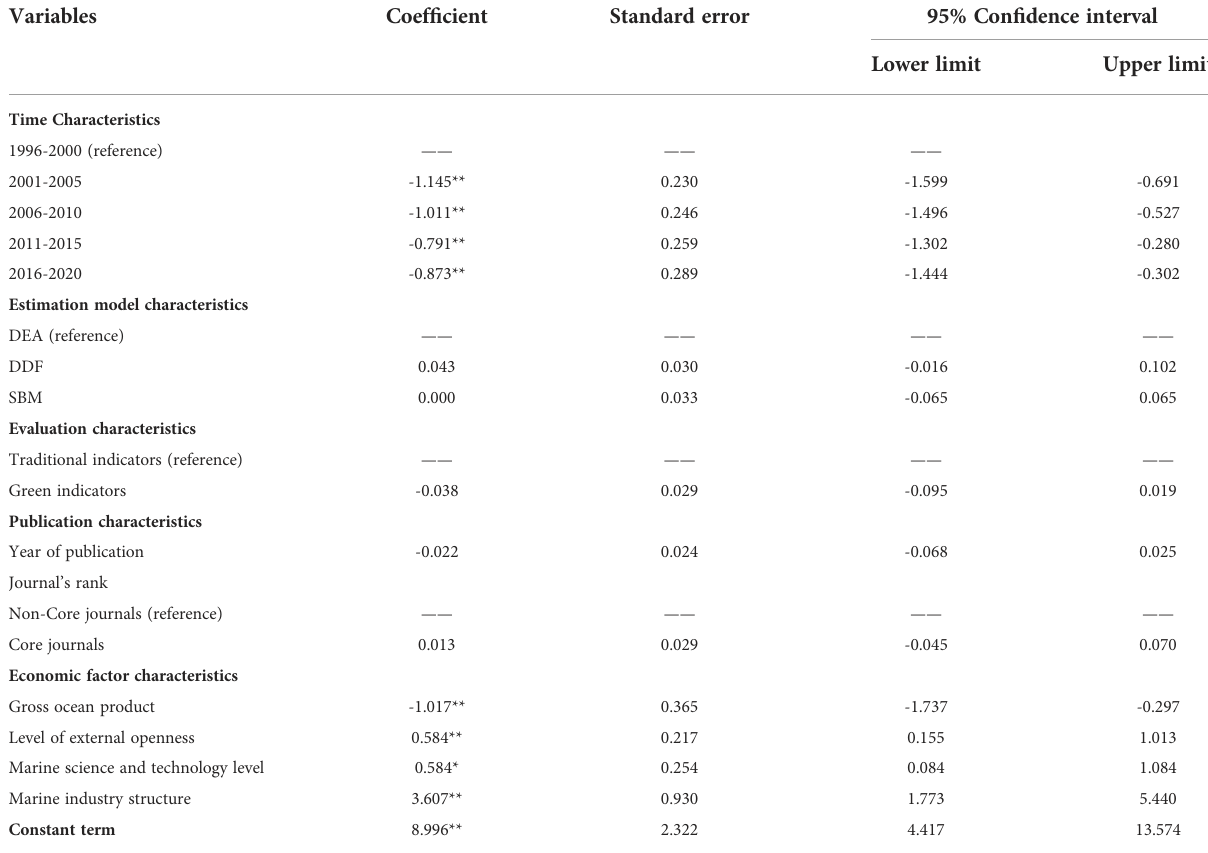
TABLE 7 The meta-regression results at the national